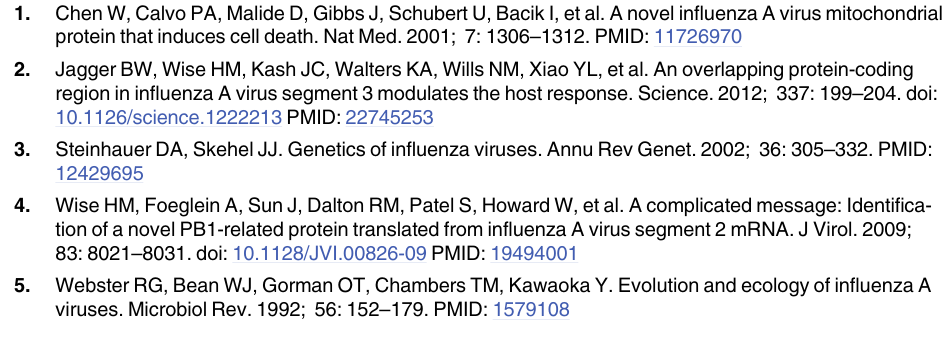
classical swine), dark blue-human isolates from North America; orange- human isolates from Eurasia, and pink- 2009 pandemic isolates. (TIF) S6 Fig. Evolutionary relatedness of NS gene segments of H1N1 IAVs of avian, swine and human origins isolated from North America and Eurasia. The taxa are colored based on their host and geography: red-North American avian isolates from the St. Jude repository, light blue-North American avian isolates, purple-Eurasian avian isolates, green- swine isolates from North America, grey- swine isolates from Eurasia (both Eurasian avian-like swine and Eurasian classical swine), dark blue-human isolates from North America; orange- human isolates from Eurasia, and pink- 2009 pandemic isolates. (TIF) S1 Table. H1N1 IAVs of avian, swine, and human origin from North America and Eurasia that were used in this study and their GenBank accession numbers for 8 gene segments. S2 Table. Amino acid substitutions at the HA antigenic sites in avian, human, and pan- demic H1N1